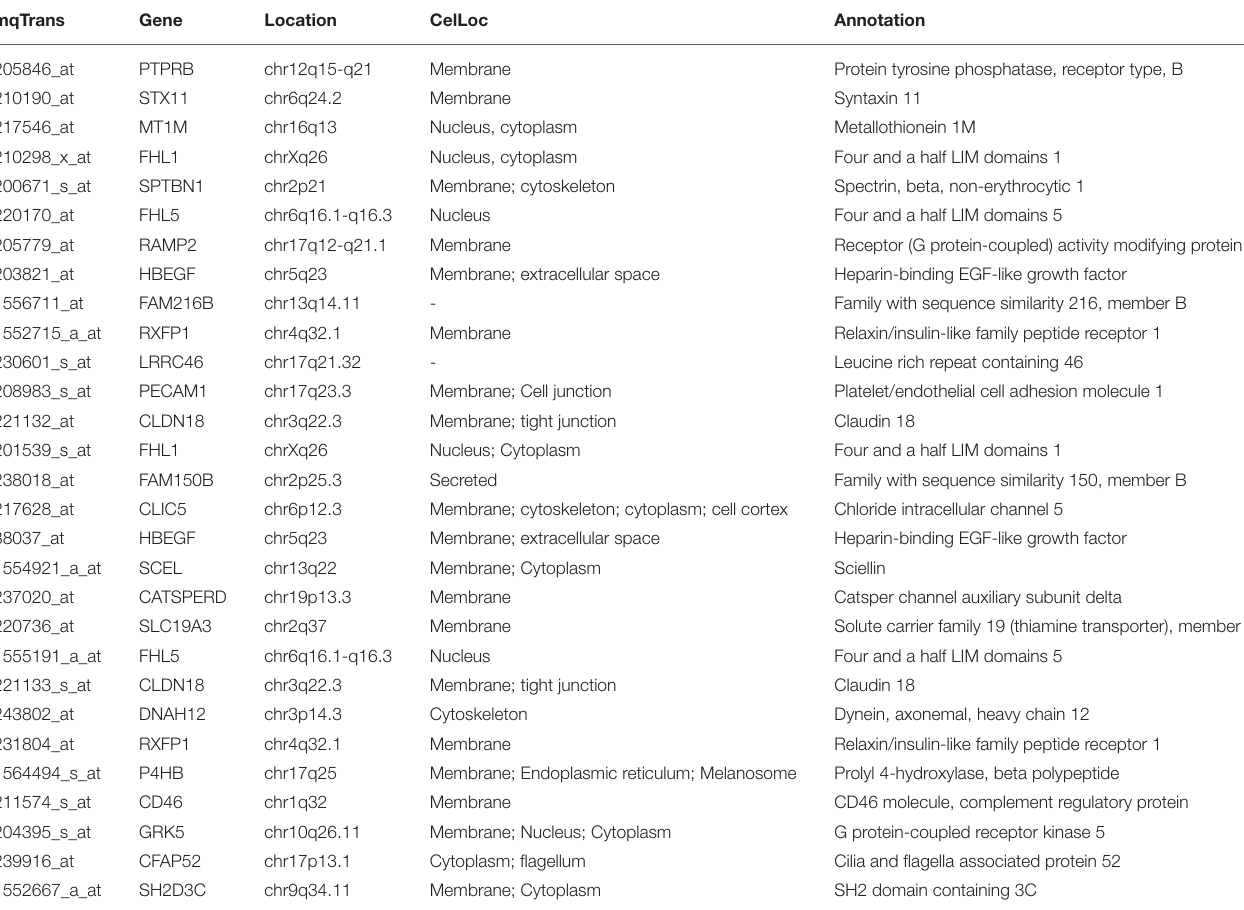
TABLE 2 | Annotations of the detected mqTrans biomarkers with quantitatively altered transcriptional regulations in lung cancers.